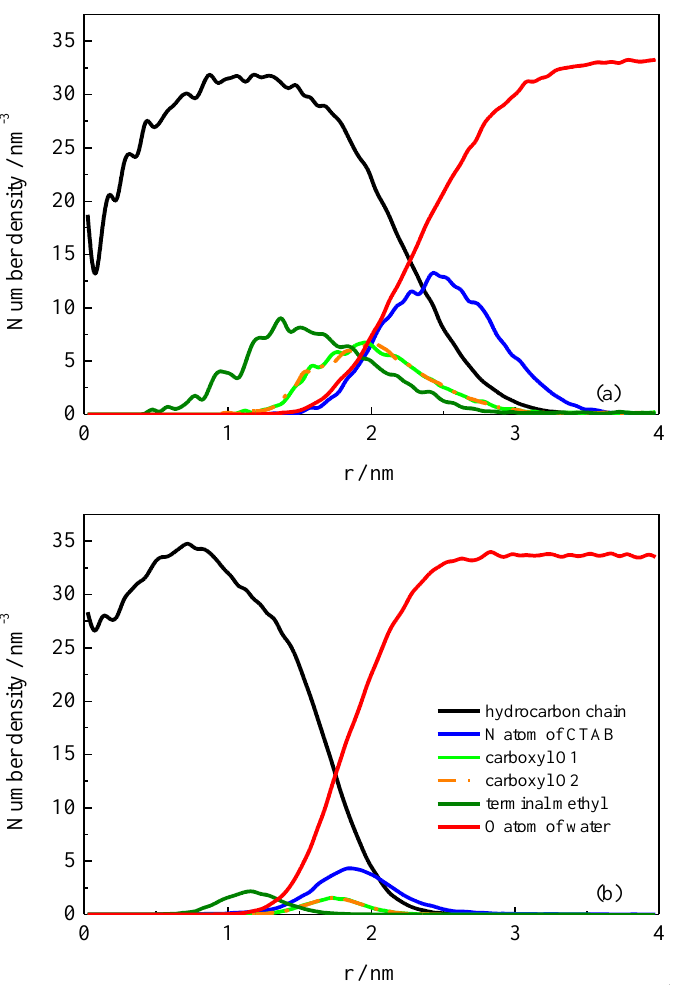
Figure 3. ( a ) Number density distributions of components with respect to the COM of the spherical micelle. Values for N1, O1, O2, and C8 (see Figure 8) were increased 10 times for clarity. ( b ) Number density distributions of components with respect to the central axis of the rod-like